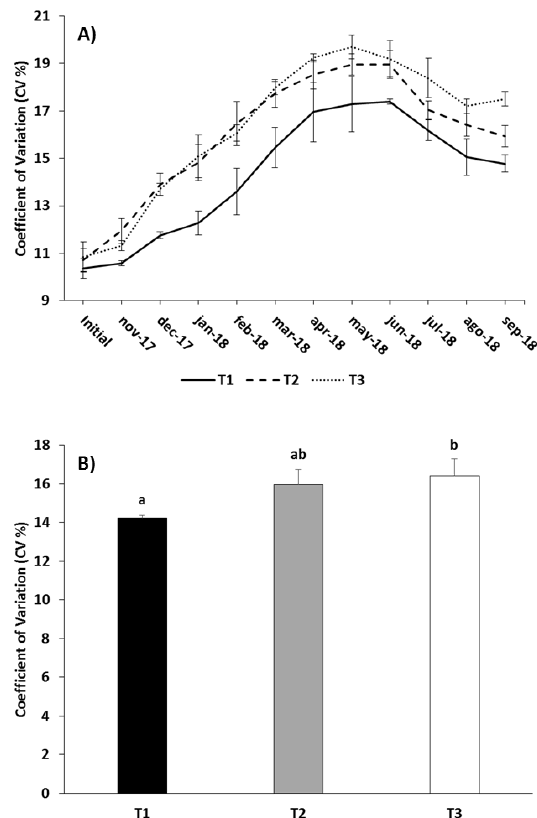
Figure 3. Monthly ( A ) and overall ( B ) values of the coefficient of variation (CV) in the different experimental feeding treatments (mean ± standard error). Different letters above the columns indicate significant differences (Tukey HSD, P < 0.05) between feeding treatments.